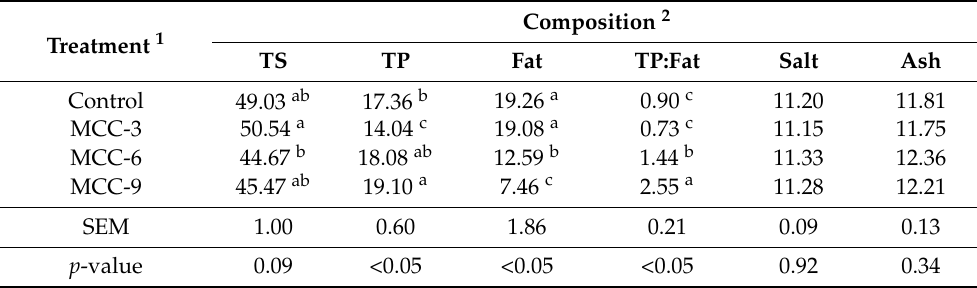
Table 3. Mean (n = 3) composition values (% by weight) of Feta-type cheese made from micellar casein concentrate (MCC).